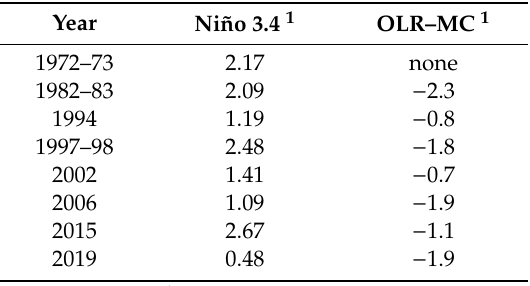
Table 1. Fire years under El